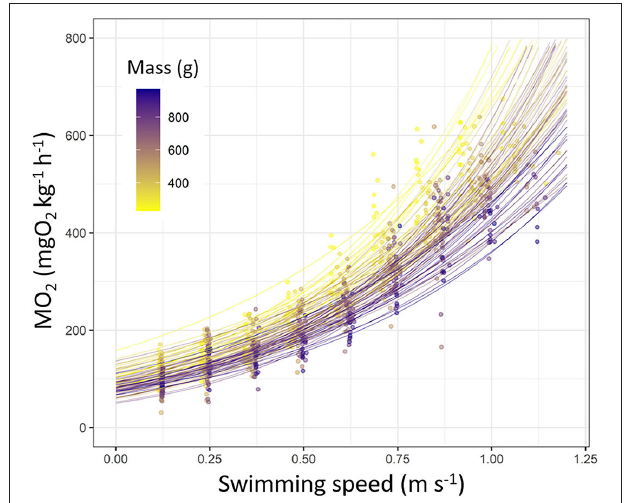
FIGURE 2 | Oxygen consumption rate (MO 2 , mgO 2 kg − 1 h − 1 ) fitted as a function of swimming speed (m s − 1 ) in European sea bass ( Dicentrarchus labrax ; n = 90). Each line represents a fish based on exponential model (statistics details are provided in Supplementary Table S3 ). Each dot represents a value obtained during U crit trial. Dots and line color are referring to the fish mass (from 200 to 1,000g; from yellow to dark blue).